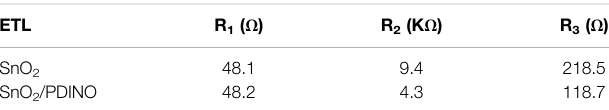
TABLE2| ResistancemetricsoftheequivalentcircuitforOSCsbasedondifferent ETLs.